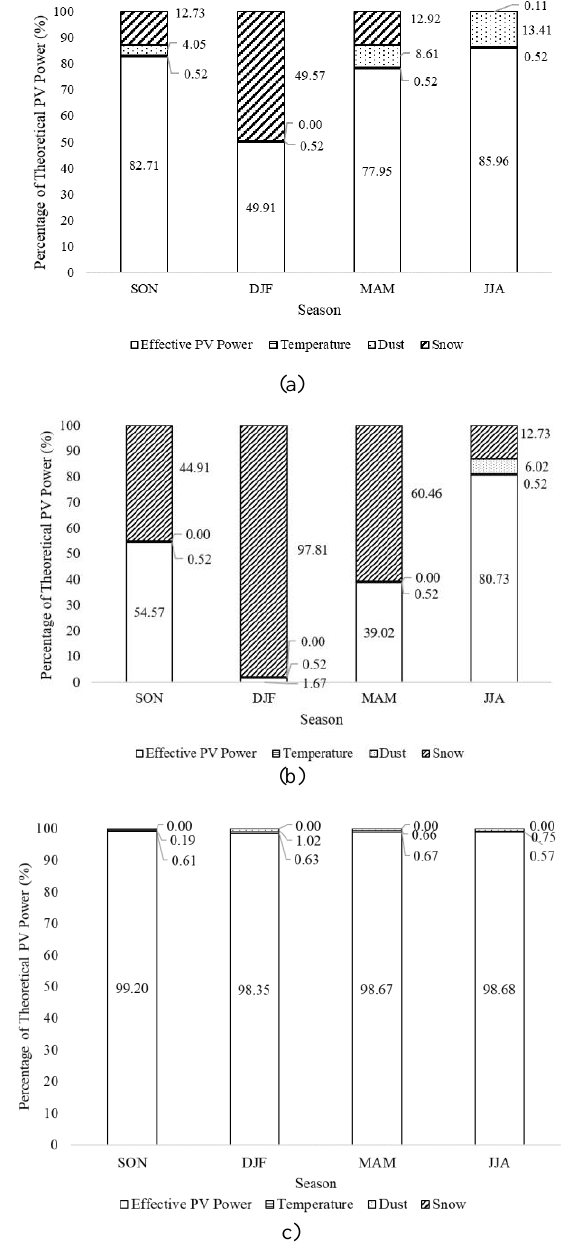
Figure 6. Decrease in PV power due to snow, dust and temperature, and the resulting effective PV power (labels from top to bottom, respectively, for each season) as percentages of the theoretical solar PV power ( P PV ) in (a) Beijing, China; (b) Khabarovsk, Russia; and (c) Jakarta,